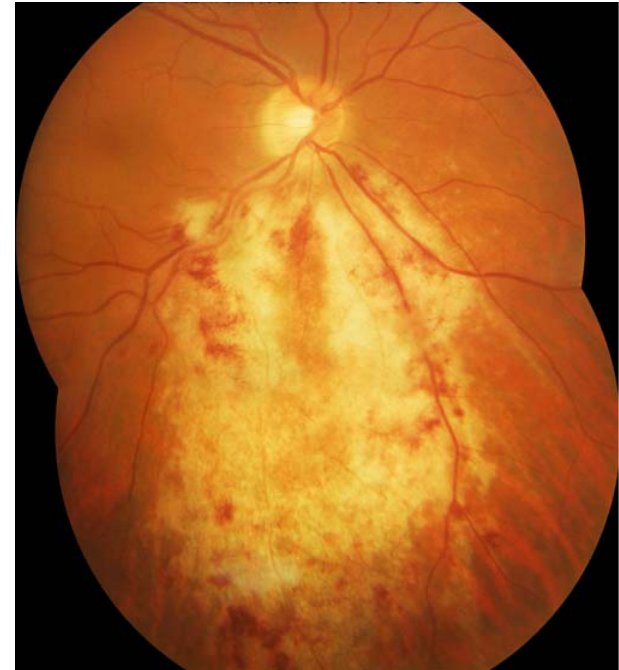
Figure 1. Example of CMV